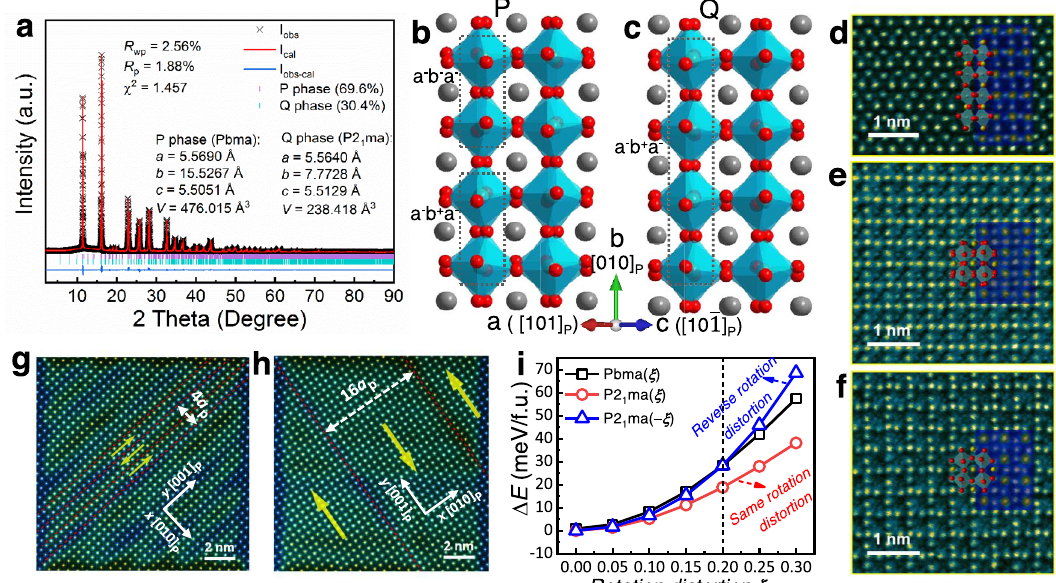
Fig. 1 | Structure and DFT calculations of NN. a Rietveld-re fi nement plot and the re fi ned results of SXRD. Schematic crystal structures of the ( b ) P phase and c Q phase. d BFSTEMimagetakenfrom[101] p zoneaxis,showingthesametiltmodeof P and Q phases. e BF STEM image taken from [010] p zone axis showing P phase structure. f BFSTEMimagetakenfrom[010] p zoneaxisshowingQphasestructure. The annular dark fi eld (ADF) images and structural schematics are overlaid in ( d ), ( e ),and ( f ),respectively. g ADFSTEMimage takenfrom[100] p zoneaxisshowingP phase structure. h ADF STEM image taken from [100] p zone axis showing Q phase structure.ThecorrespondingGPAshearstrain( ∂ u y ∂ x )oftheADFSTEMimagesisalso